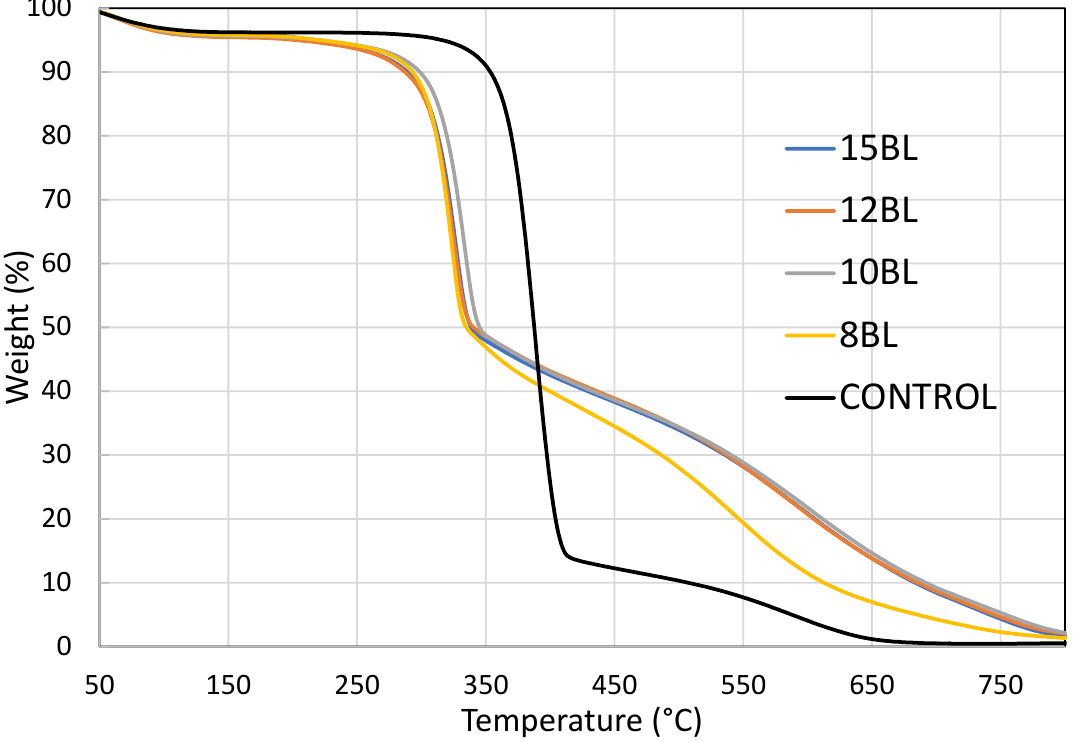
Figure 3. Cotton weight as a function of temperature for untreated and LbL-treated samples.